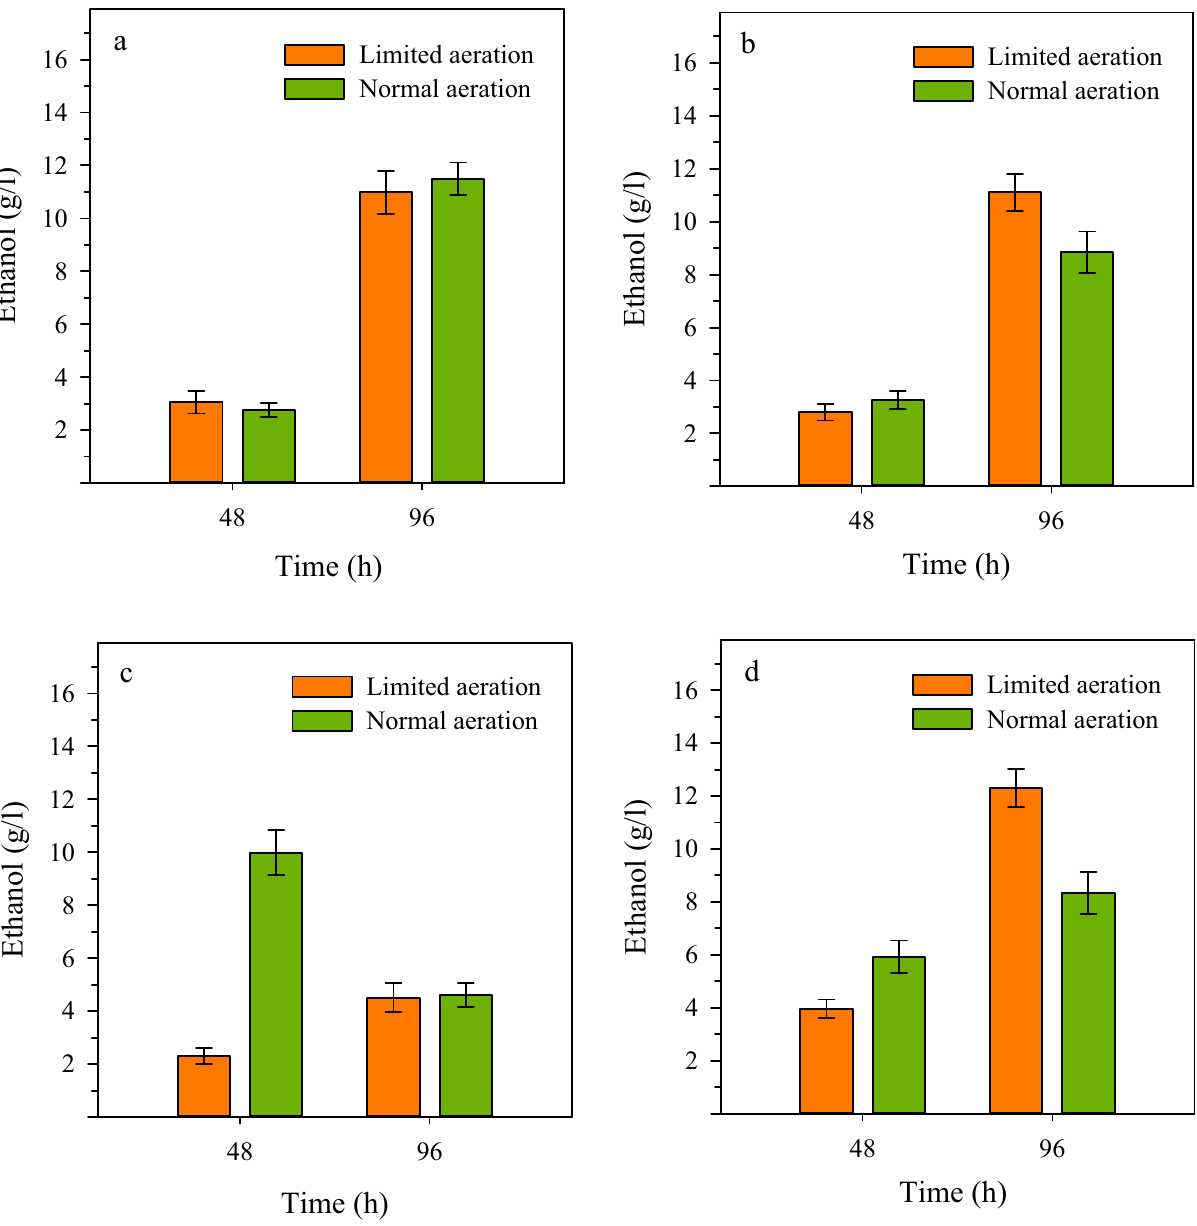
Figure 4. The combinatorial influence of aeration, temperature, and shaking conditions on ethanol production by strain NZS (Δ ldh , pdc Z -adh S ). Cultures with limited and normal aeration were incubated at: ( a ) 30 °C, 120 rpm; ( b ) 30 °C, 180 rpm; ( c ) 37 °C, 120 rpm; and ( d ) 37 °C, 180 rpm. Samples obtained at 48 h and 96 h of fermentation were analyzed for ethanol